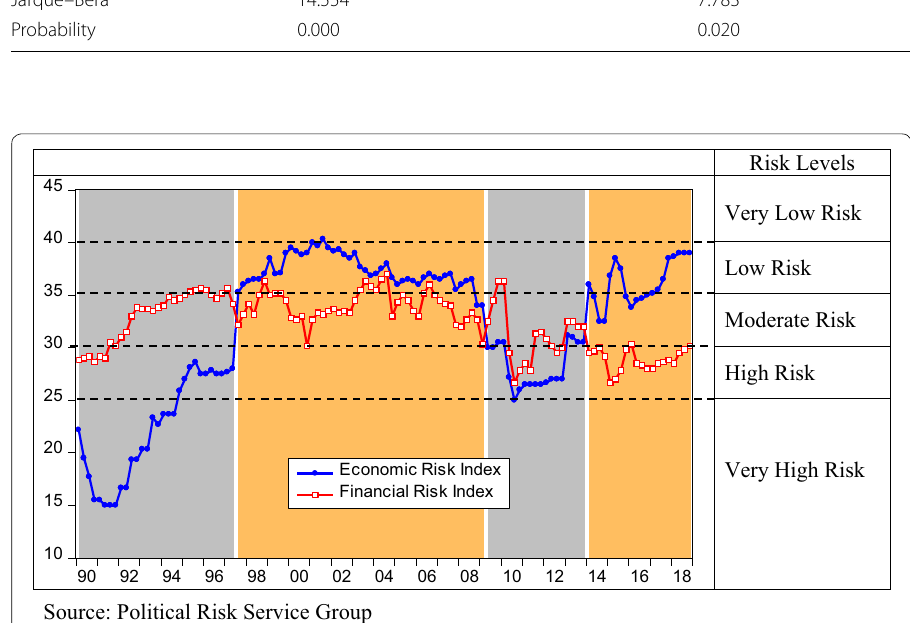
Fig. 1 Economic risk index and financial risk index in